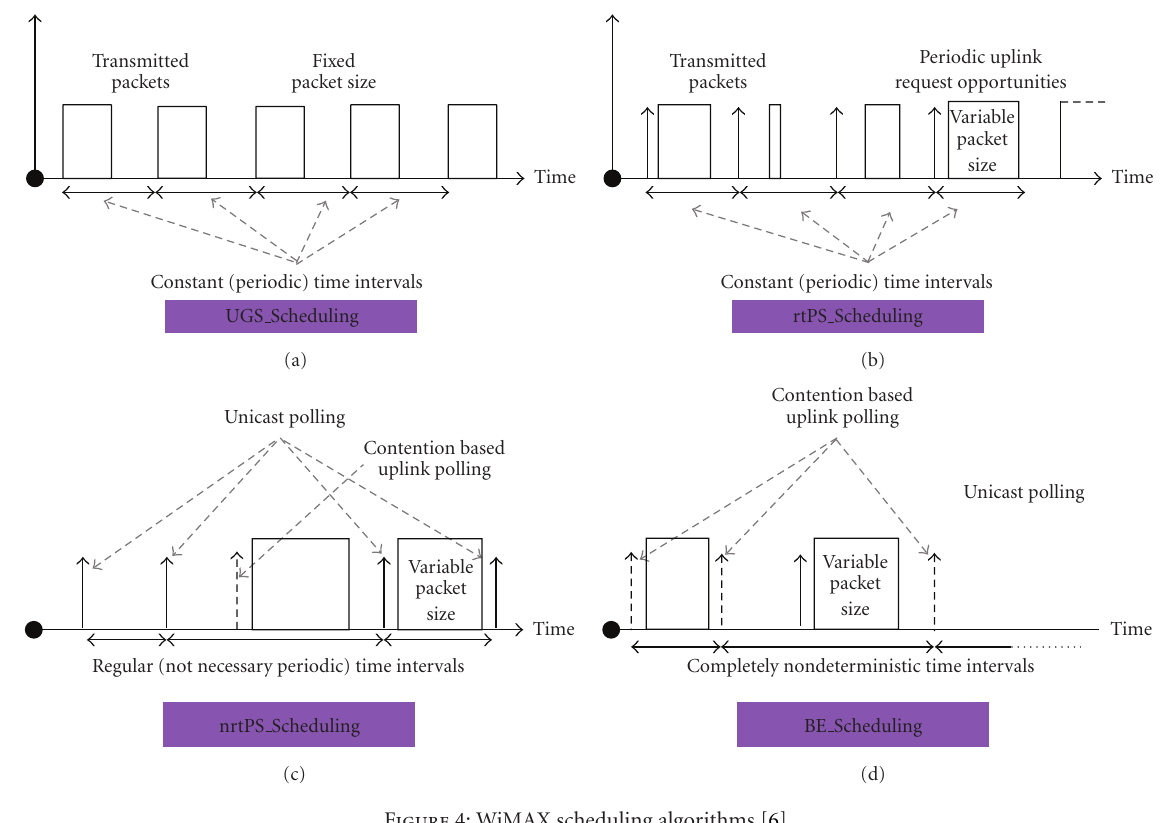
Figure 4: WiMAX scheduling algorithms